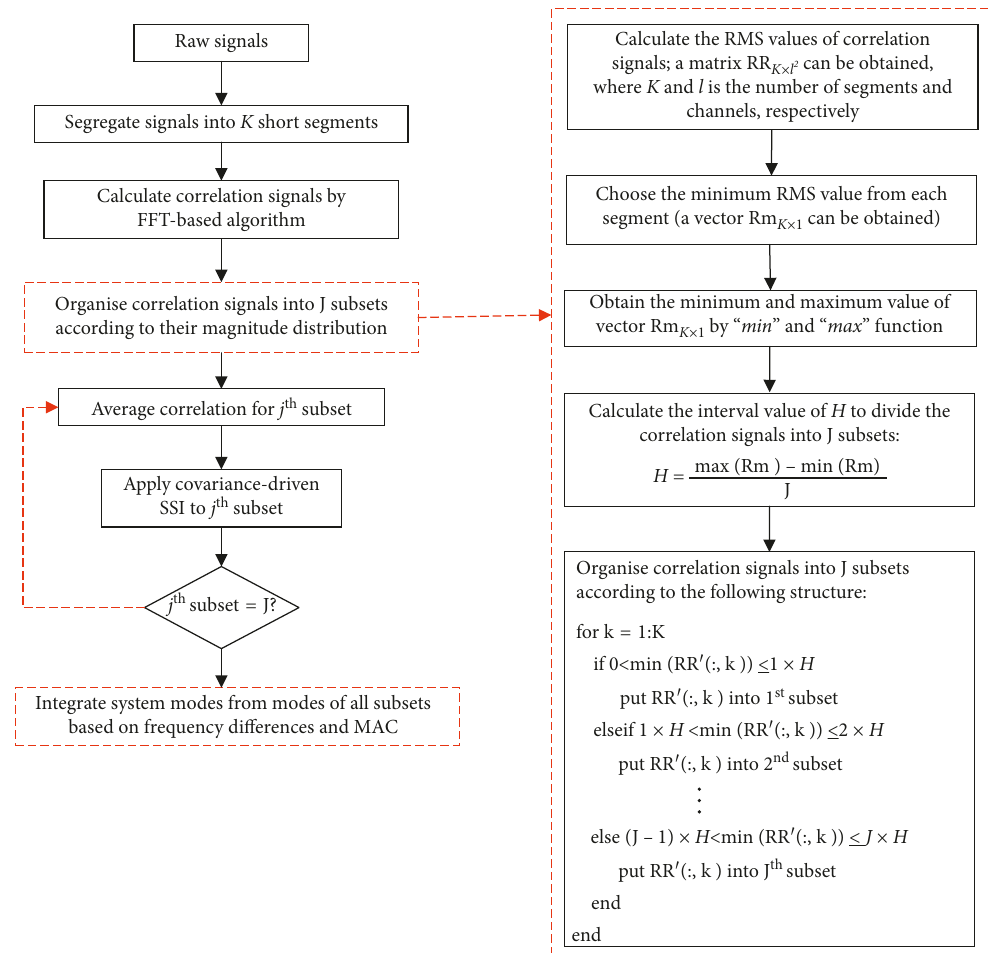
Figure 1: Flow chart of